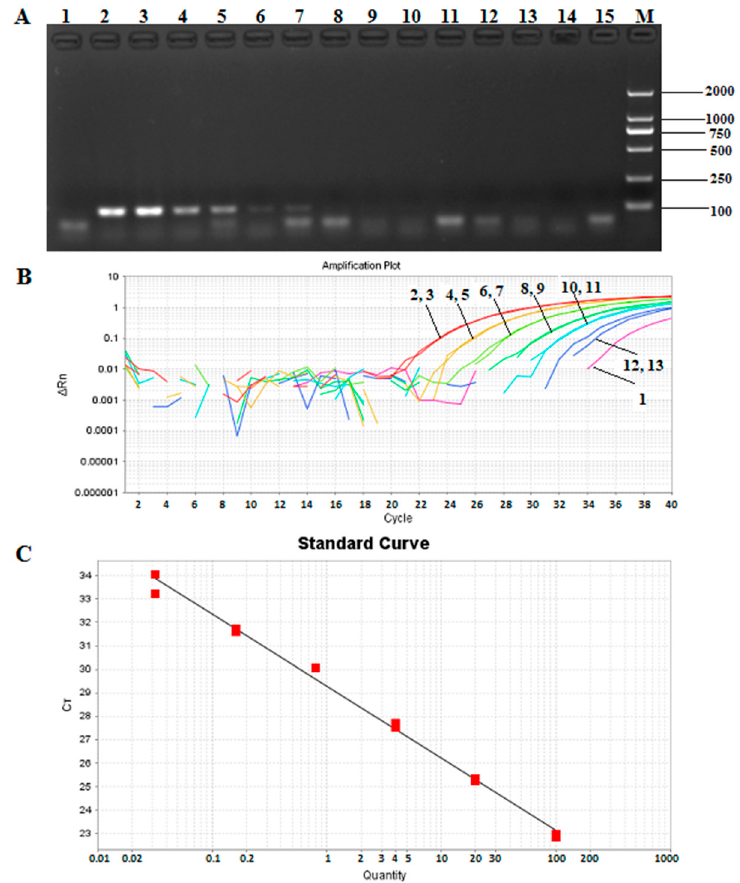
Figure 5. Sensitivity of the Pol gene detection in qualitative and Taqman quantitative PCR. ( A ) Sensitivity detection of Pol gene by conventional PCR. 1: negative control; 2–3: 200 ng; 4–5: 40 ng; 6–7: 8 ng; 8–9: 1.6 ng; 10–11: 0.32 ng; 12–13: 0.064 ng; 14–15: 0.0128 ng; M: DNA marker DL 2000; ( B ) the amplification curves of Pol gene by quantitative PCR. 1: negative control; 2–3: 100 ng; 4–5: 20 ng; 6–7: 4 ng; 8–9: 0.8 ng; 10–11: 160 pg; 12–13: 32 pg; ( C ) the standard curve of the sensitivity detection of Po l gene by qPCR.